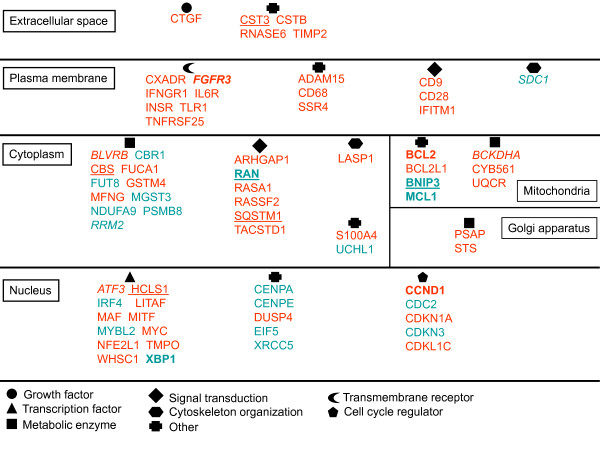
Schematic representation of genes involved in the pathogenesis of MM. We compared our microarray data with some previously published [37-41]. We then sorted genes characterized in our study and at least another one; genes cited in more than two studies are in bold. Genes are listed according to their subcellular localization and cellular function (symbols are explained under the scheme). Overexpressed genes are in red, underexpressed genes are in green. Genes altered by cyclin D1b expression are in italic, genes altered by both cyclins D1b and K are underlined.